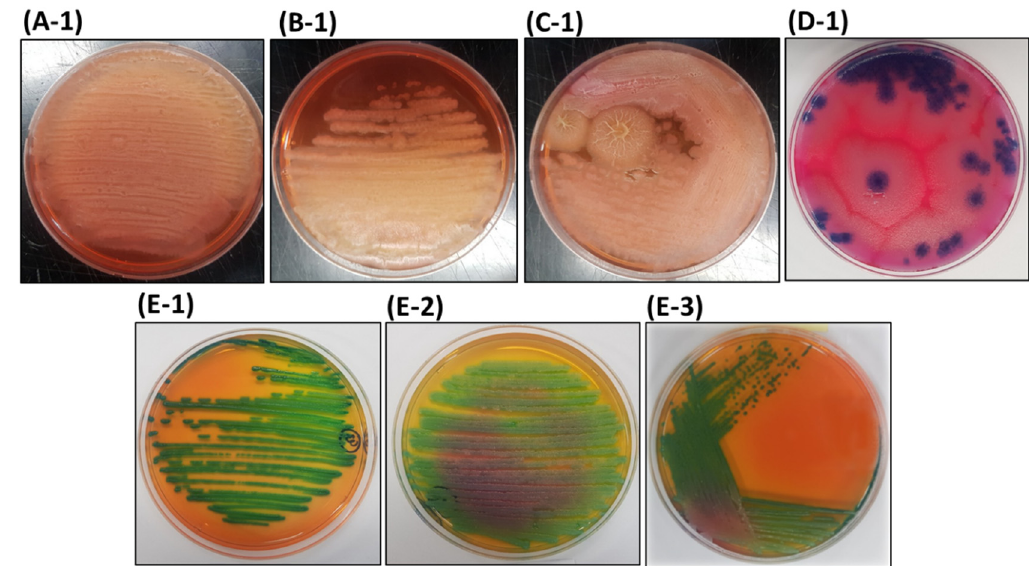
Figure 2. Morphology of bacterial colonies isolates from different commercially available organic agriculture materials enriched with effective microorganisms on HiCrome™ Bacillus agar. A-1, B-1, C-1, D-1, E-1, E-2, and E-3 are the bacterial isolates from AMEM-A, AMEM-B, AMEM-C, AMEM-D, and AMEM-E, respectively.